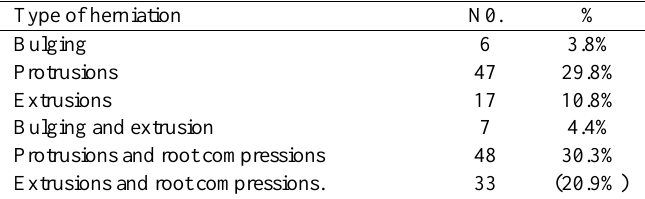
Table 3: Type of disc herniation level by